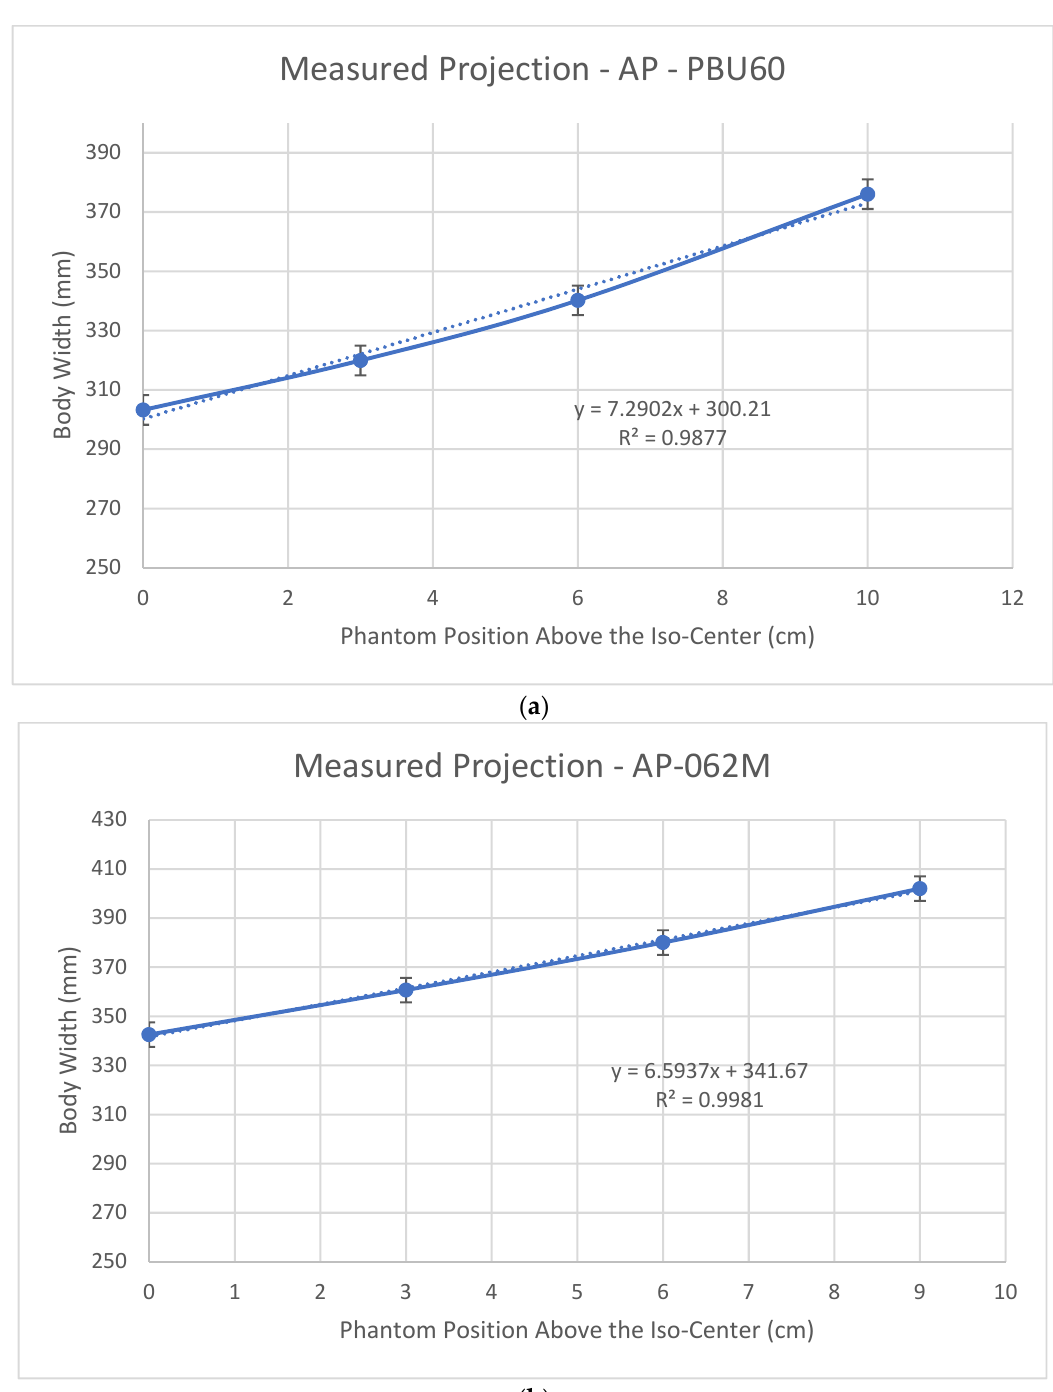
Figure 4. Measured body widths from the SPR images using an AP localizer: ( a ) the PBU60 phantom using the HD750 scanner; ( b ) the 062M phantom using the APEX scanner.